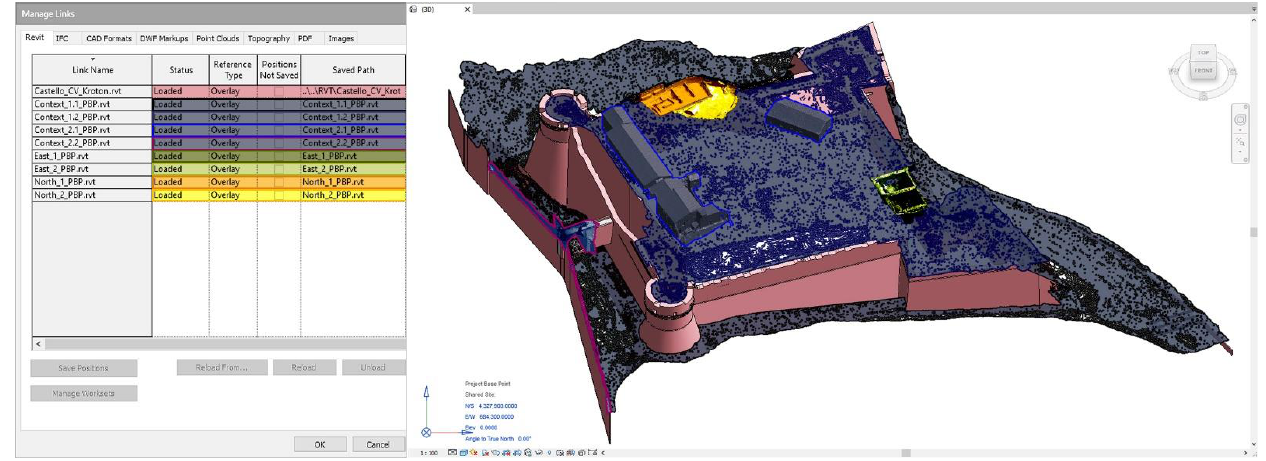
Figure 13. Overview of the federated linked models, georeferenced via the “Project Base Point”.